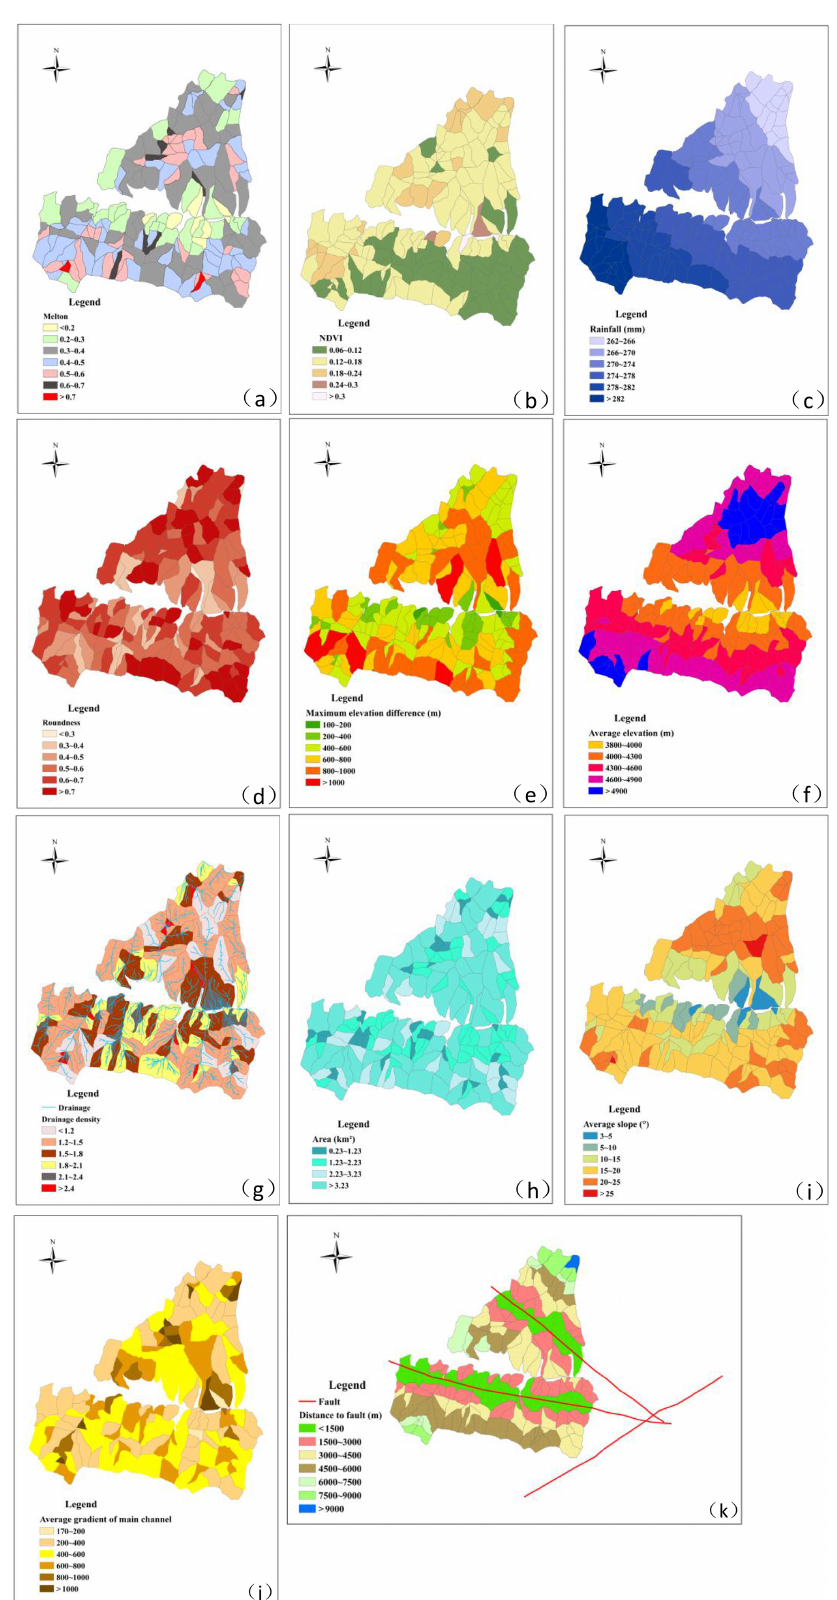
Figure 6. Study area thematic maps for debris flow: (a) Melton, (b) NDVI, (c) rainfall, (d) roundness, (e) maximum elevation difference, (f) average elevation, (g) drainage density, (h) area, (i) average slope, (j) average gradient of main channel and (k) distance to fault. Nat. Hazards Earth Syst. Sci., 21, 1247–1262, 2021